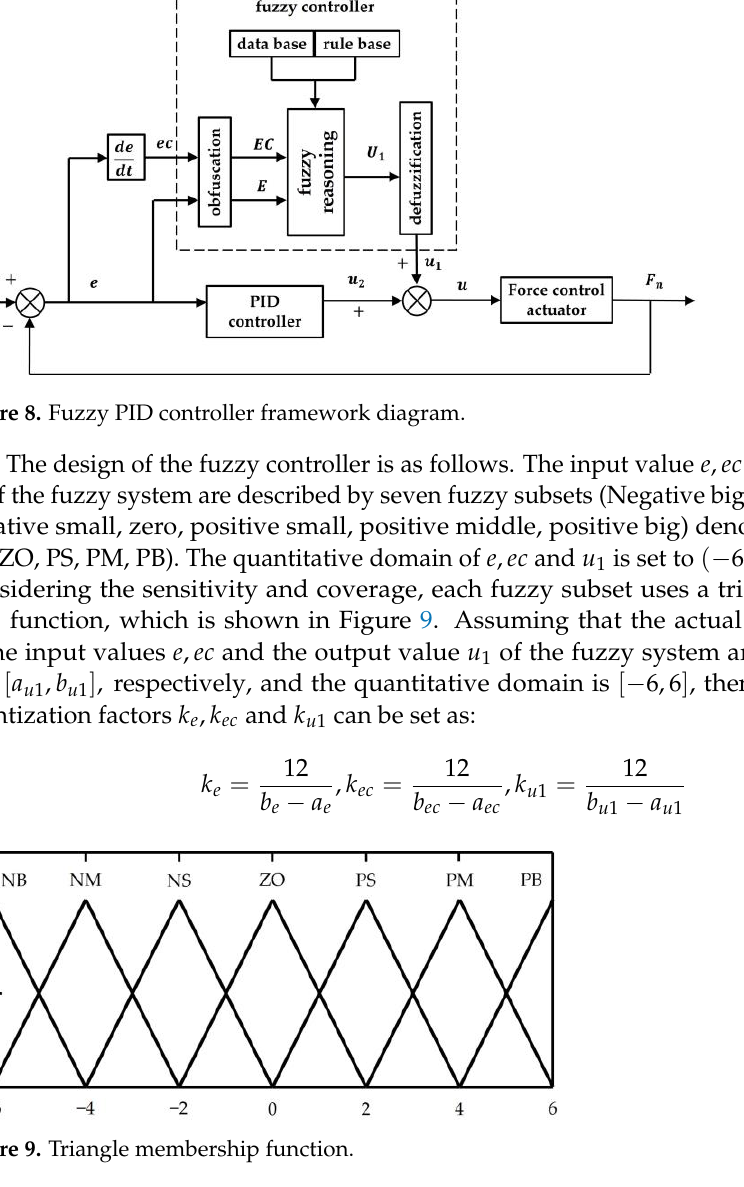
Table 2 is the established fuzzy control rule table. Figure 9. Triangle membership Figure 9. Triangle membership function. Table 2. Fuzzy control rules table.